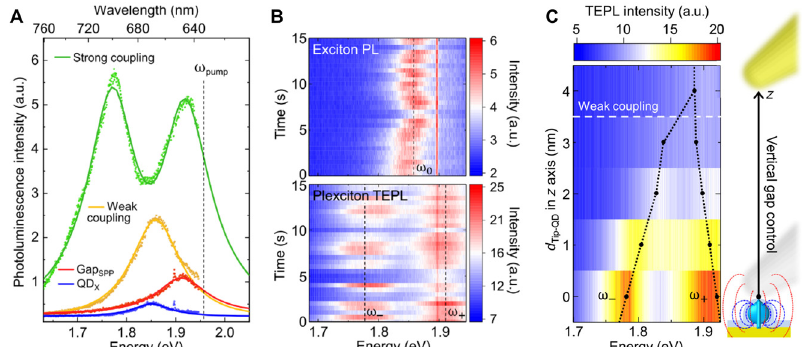
optical antenna-tip [59]. Figure 9A shows a schematic di- agram of the measurement setup equipped with an inver- ted mode microscope and a tuning fork based shear force AFM. The SWCNTs are excited by radially polarized 594 nm or 633 nm continuous wave HeNe laser, and the back- scattered far- fi eld PL or TEPL signals are detected by an APD and a charge coupled device (CCD). In the detection beam path, a rotating linear polarizer is used to investigate radiation direction of PL (Figure 9B). Since 1D carbon nanotubes can be thought as a chain of point dipole emitters, we expect linearly polarized dipolar emission from the sample. Figure 9C shows simulated radiation patterns for in-plane ( θ = 90 ° , left) and out-of-plane ( θ = 0 ° ,